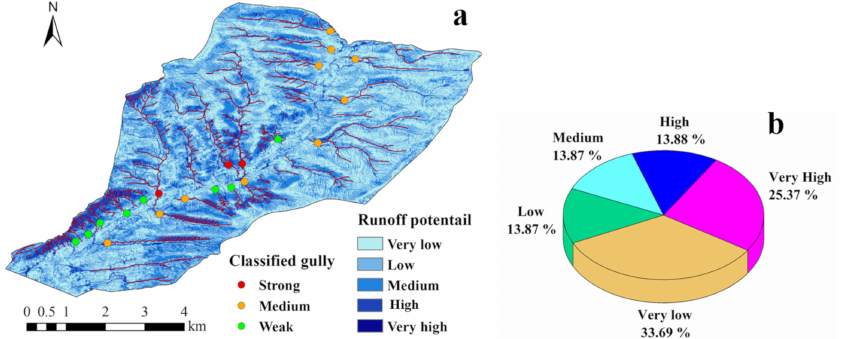
Figure 4. Runo ff potential and gullies (strong, medium and weak) location. ( a ) runo ff potential map; ( b ) percentage of area covered by di ff erent runo ff